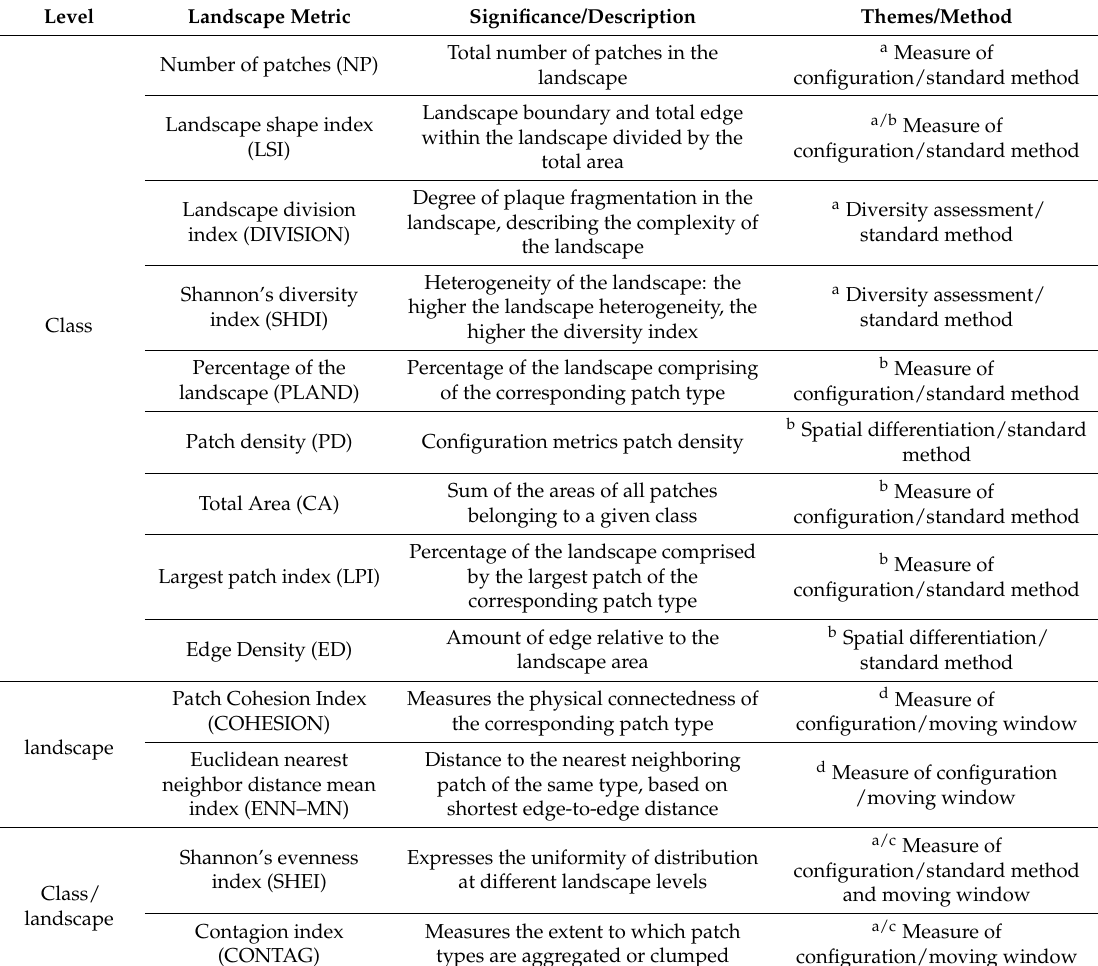
Table 2. Commonly-used landscape